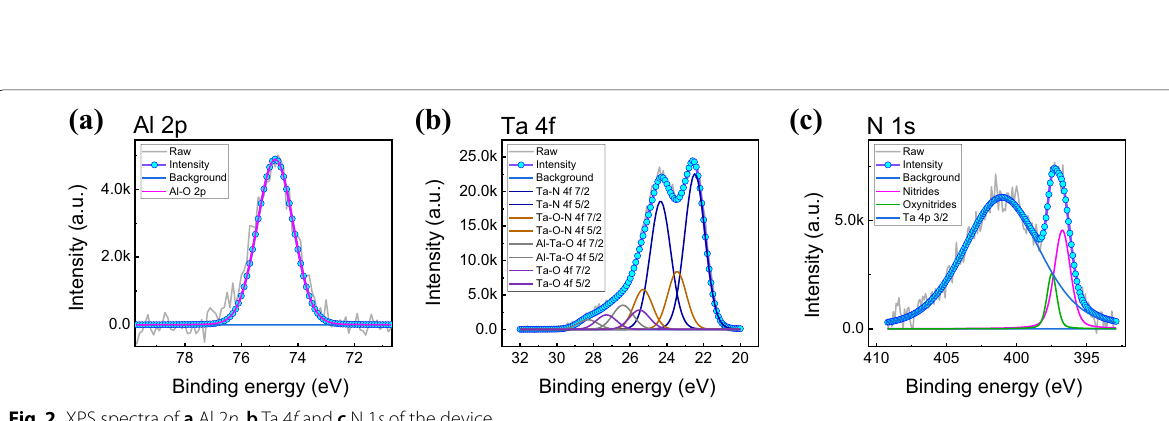
Fig. 2 XPS spectra of a Al 2 p , b Ta 4 f and c N 1 s of the